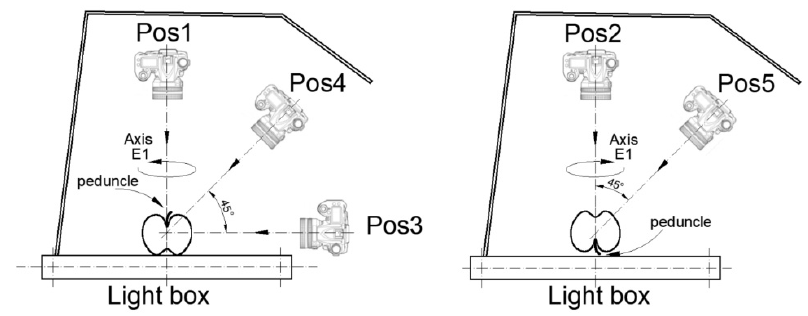
Figure 4. Positions from which the apple samples were photographed.